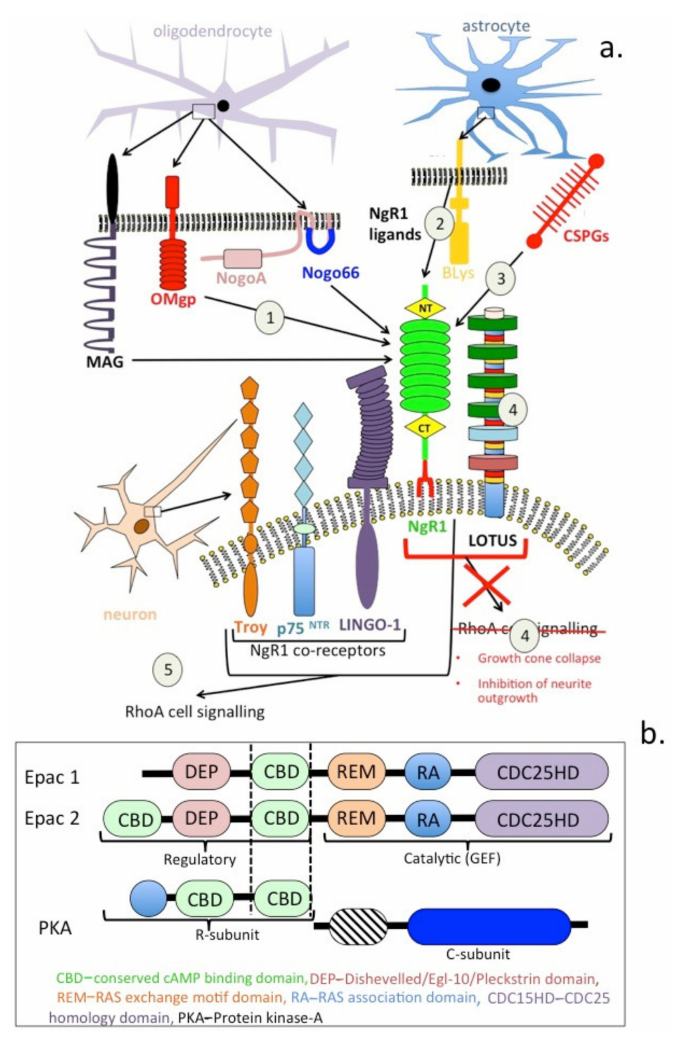
Figure 4. Schematic representation of the NgR1 Nogo receptor and Nogo co-receptors (Troy, p75 NTR and Lingo-1) expressed by neurons, which collectively produce an inhibitory, proliferative and neurite extension signal upon binding of AGIs such as MAG, OMgp, NogoA and Nogo 66 ( a ) produced by oligodendrocytes (1) and BLys (2), or CS-PGs (3) produced by astrocytes, with the cytoplasmic domains of the co-receptors promoting RhoA signalling ( a ). Depiction of the LOTUS NgR1 antagonist which blocks RhoA signalling (4), growth cone collapse and the inhibition of neurite outgrowth induced by AGIs (5). Modular structure of Epac1 and 2 (cAMP-regulated guanine nucleotide exchange factors-1, 2) ( b ) which mediate the action of cAMP and protein kinase A. Epac2 transforms the post-lesional inhibitory environment following SCI to an environment conducive to axonal outgrowth and neural proliferation in a model of